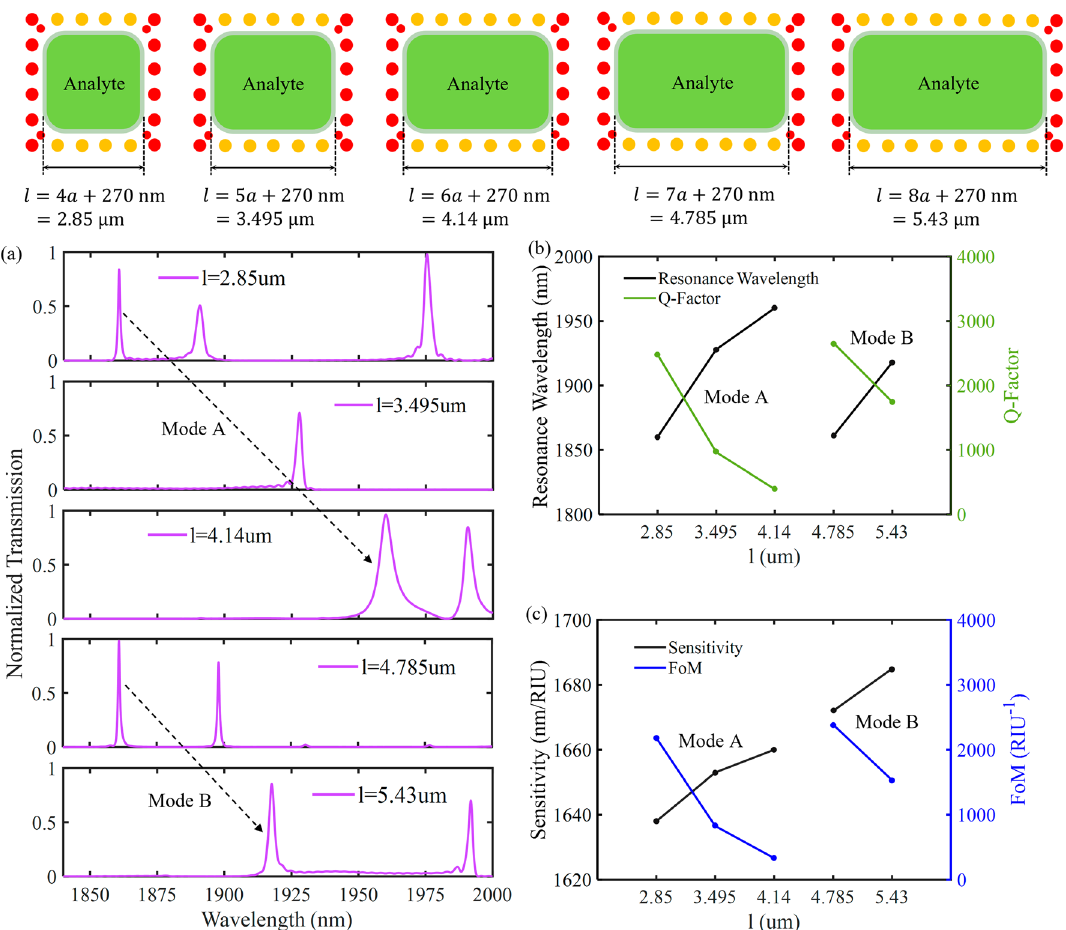
Figure 11. ( a ) The normalized transmission spectrum as a function of the analyte region length ( l ), ( b ) The effect of the length on the resonance wavelength and quality factor, ( c ) The effect of the length on the sensitivity and FoM.